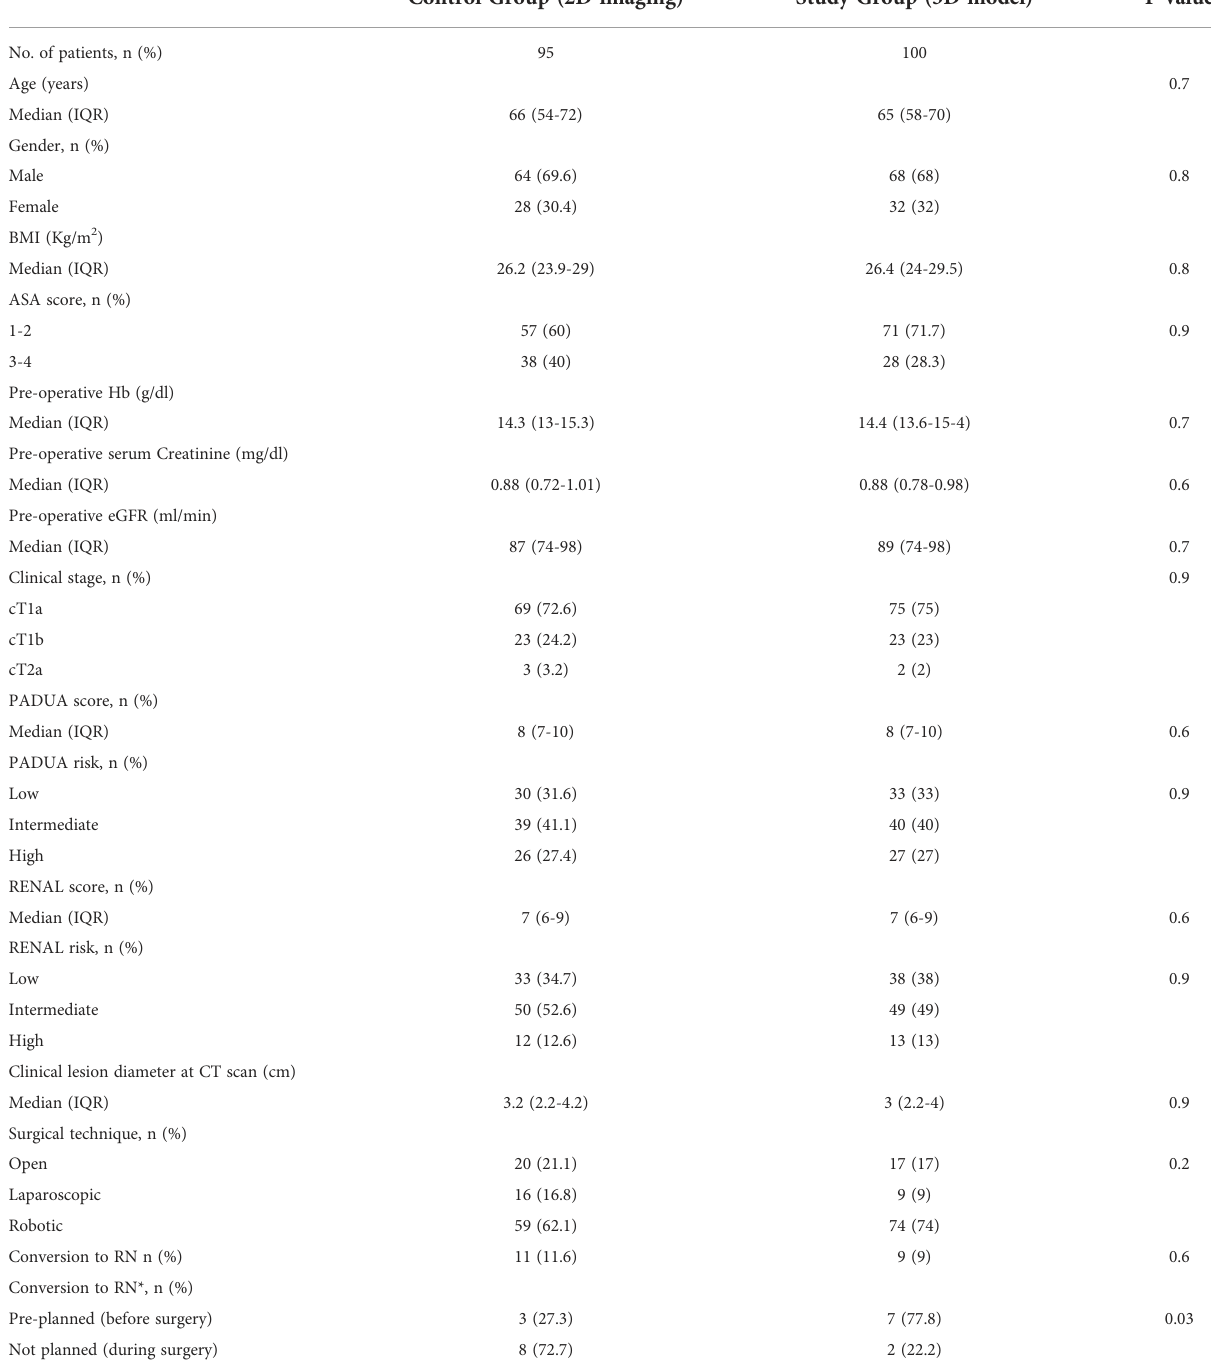
TABLE 1 Patient characteristics and descriptive statistics in the overall population